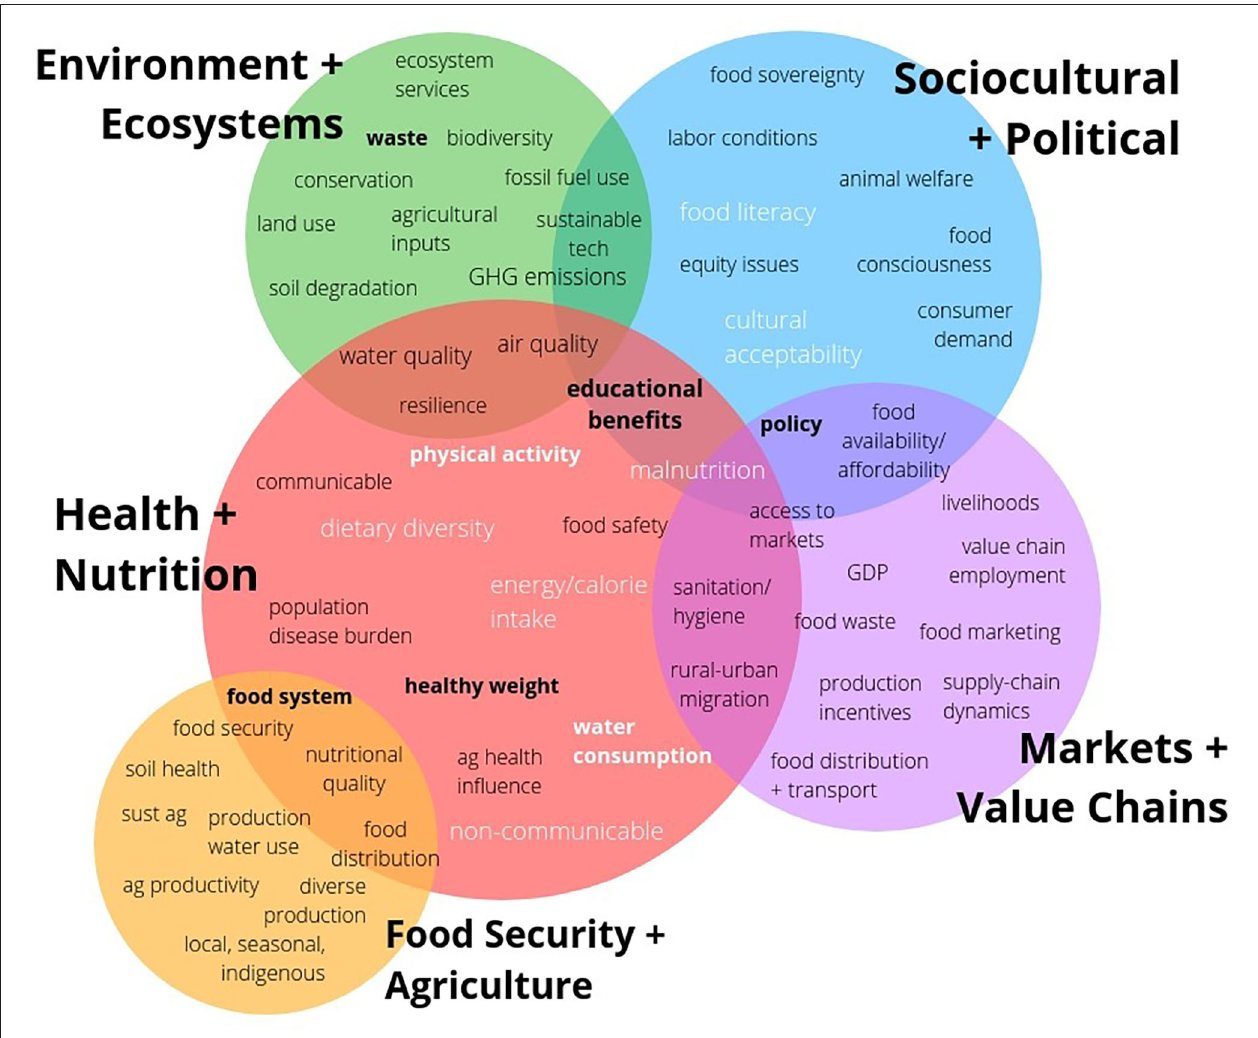
FIGURE 1 | Sustainability in Food-Based Dietary Guidelines (FBDG) Framework. Domains and concepts included in FBDGs with sustainability domains; concepts in white included in all documents reviewed ( n = 12), concepts in bold were inductively added by the author from this analysis. GHG, Greenhouse Gases; GDP, Gross Domestic Product; ag,